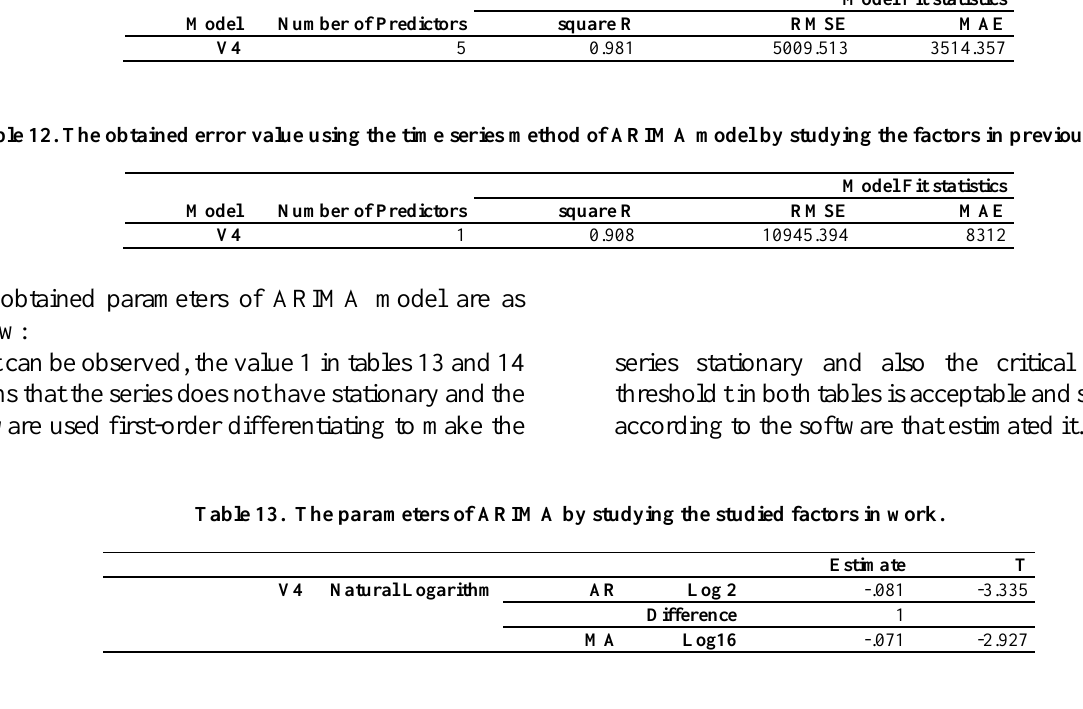
Table 14. the parameters of ARIMA by studying the factors in previous studies.